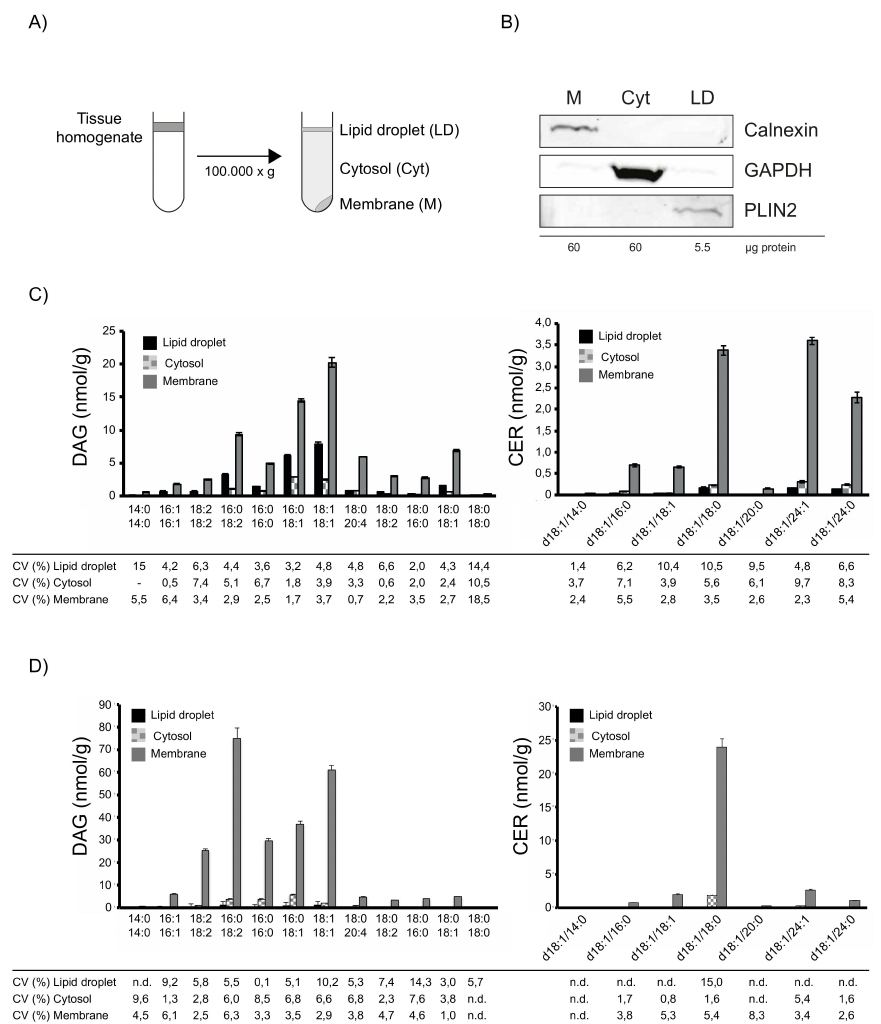
Figure 2. Subcellular fractionation and lipid analysis of human skeletal muscle. Schematic illustration of the fractionation protocol ( A ). Analysis of subcellular fractions obtained from human skeletal muscle. The protein concentration of the subcellular fractions after centrifugation was determined and the indicated amount was analysed by SDS-PAGE and western blotting using the indicated antibodies, Calnexin (ER); GAPDH (Cytosol); PLIN2 (LD) ( B ). Lipid mass spectrometry analysis of human muscle fractions. Human muscle sample was processed in triplicates and DAGs and CERs were analysed. Data are presented as mean ± SD. Correlation coefficient (CV) of individual lipid species in the indicated fraction is given in percent ( C ). Lipid mass spectrometry analysis of mouse muscle fractions. Mouse muscle sample was processed in triplicates and DAGs and CERs were analysed. Data are presented as mean ± SD. Correlation coefficient (CV) of individual lipid species in the indicated fraction is given in percent ( D